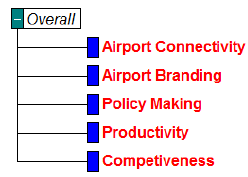
Figure 2. Value tree of the